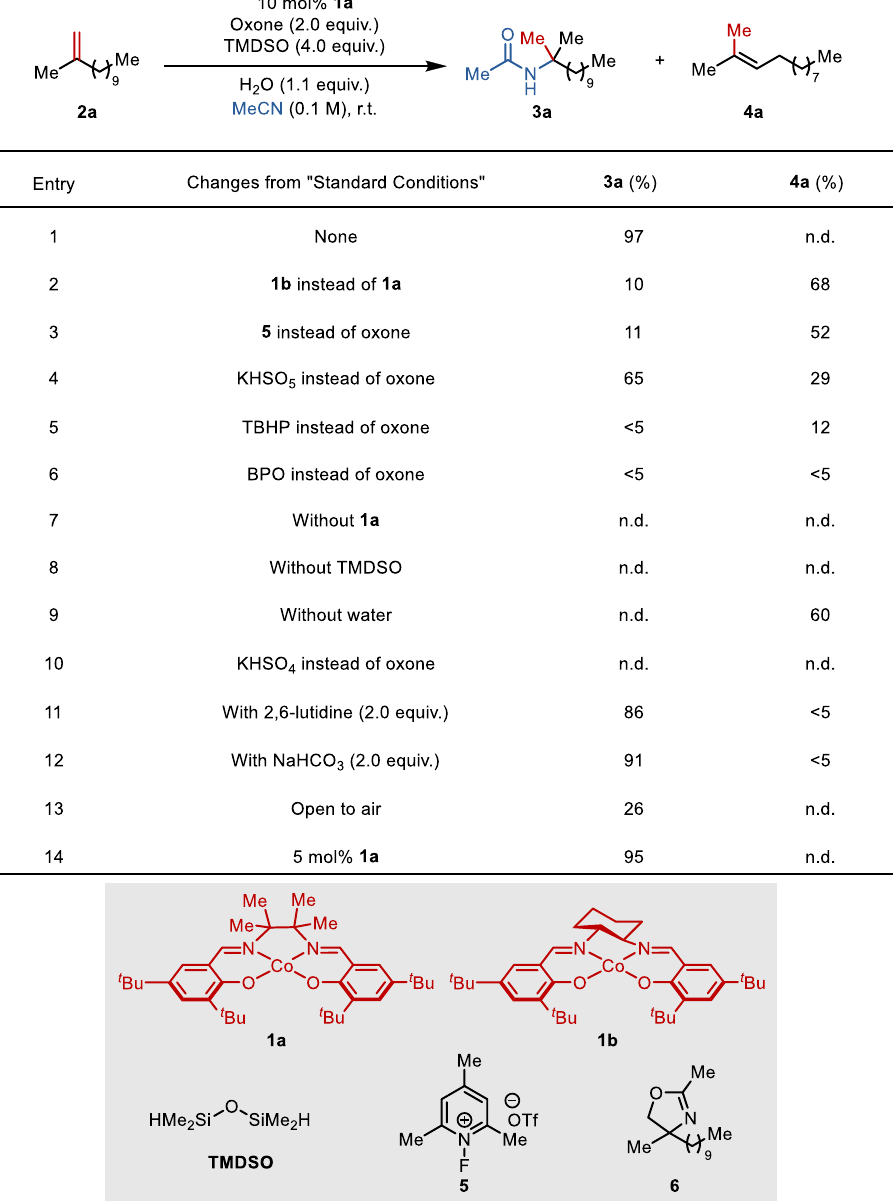
Fig. 2 Evaluation of reaction conditions. Standard conditions: 2a (0.10 mmol), 1a (10 mol%), oxone (2.0 equiv.), TMDSO (4.0 equiv.), H 2 O (1.1 equiv.) in 1.0 mL MeCN at r.t. for 18 h. Yields were determined by 1 H NMR analysis of the crude reaction mixture. TBHP tert -butyl hydroperoxide, BPO benzoyl